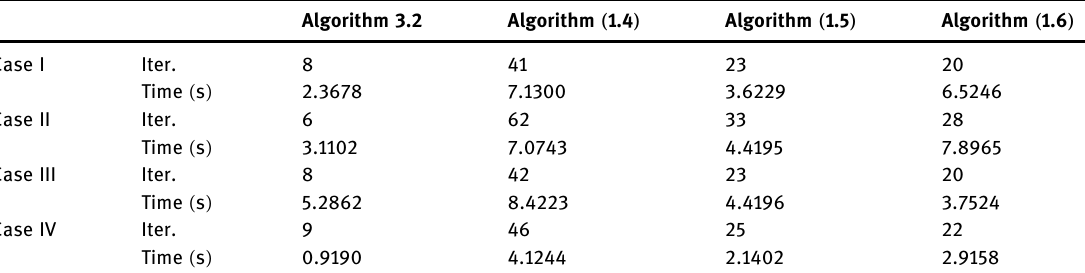
Table 4: Computation result for Example 4.2, Experiment 2 Algorithm 3.2